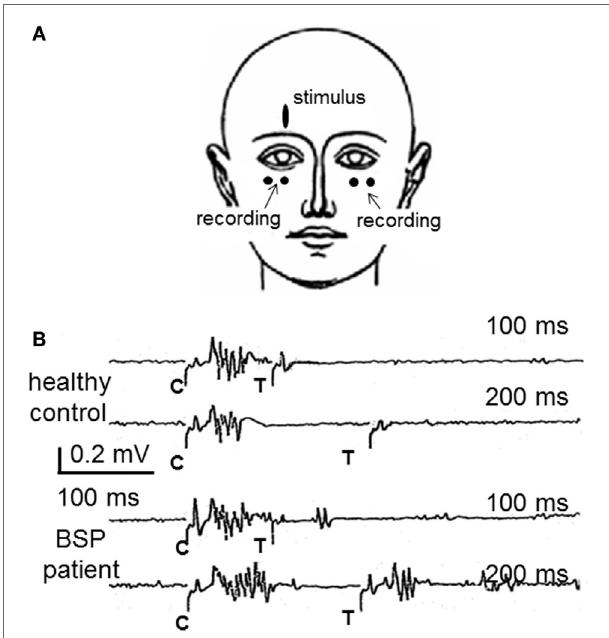
FiGURe 1 | The study of the blink reflex excitability recovery curve in blepharospasm . (A) The most frequently used method to examine patients with BSP is the recording of blink responses by surface electrodes attached over the orbicularis oculi muscles. (B) Partial results from a study of blink reflex excitability recovery in a healthy control and a BSP patient. Pair of supraorbital nerve stimuli are applied either 100 or 200 ms apart. The conditioning stimulus (C) elicits the typical blink reflex, composed by R 1 and R 2 responses. The test stimulus (T) elicits no R 2 response in the healthy control, which reflects the normal lack of excitability at such short intervals, whereas they elicit an R 2 response in the patient, larger with the interval of 200 ms, reflecting the enhanced blink reflex excitability, characteristic of BSP. Part (A) of this figure was previously published as part of Figure 19.6 of Ref. (45) and is reproduced with permission from Elsevier. Part (B) of this figure was previously published as Figure 1 in Valls-Sole’s “Assessment of excitability in brainstem circuits mediating the blink reflex and the startle reaction,” published in Ref. (41), and is reproduced with permission from